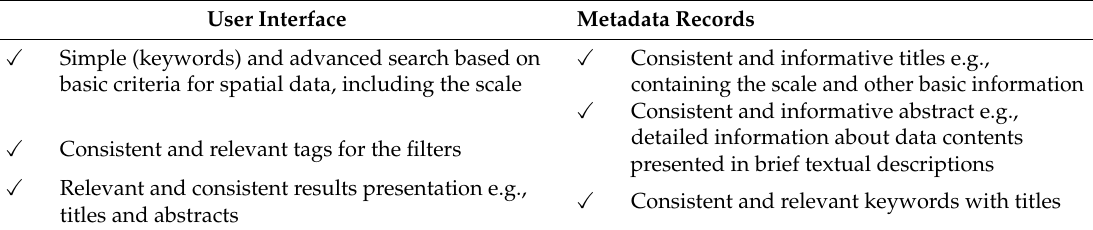
Table 7. Identified user expectations for spatial data